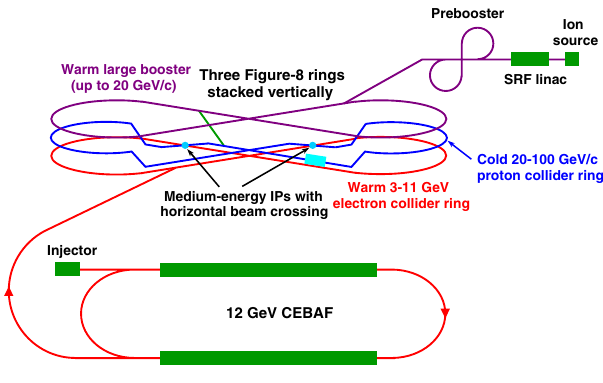
FIG. 2. Schematic layout of the proposed MEIC complex.